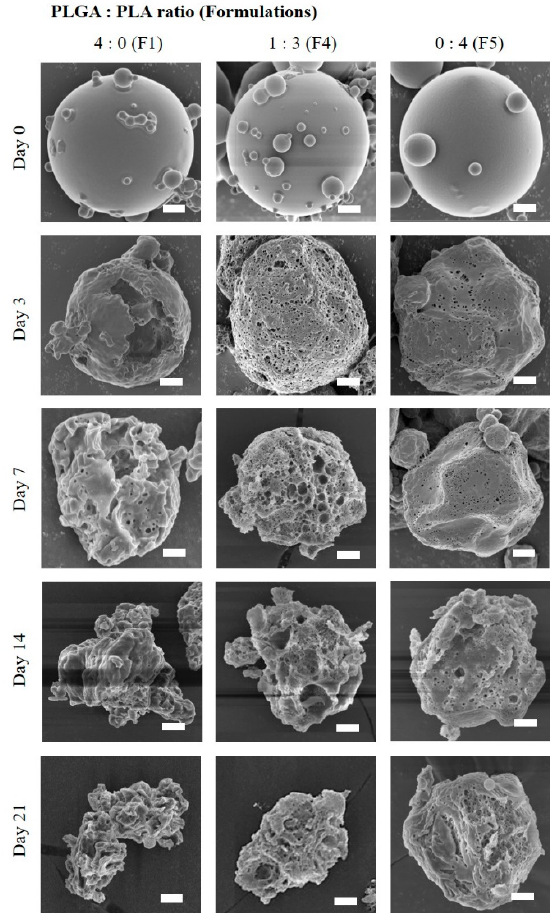
Figure 4. Morphological changes of TA microcrystals-loaded MSs prepared with different PLGA:PLA ratios, 0:4 (F1), 1:3 (F4), 0:4 (F5) under the accelerated release conditions (45 °C); Note: Scale bars in each image indicate 2.0 μ m.